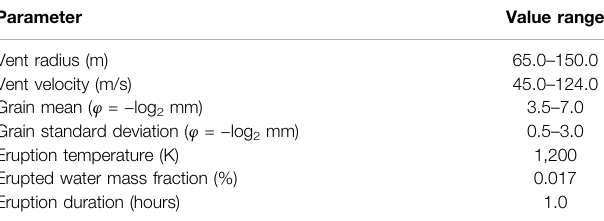
TABLE 5 | Eruption source parameters for a hypothetical eruption of Kelut volcano.